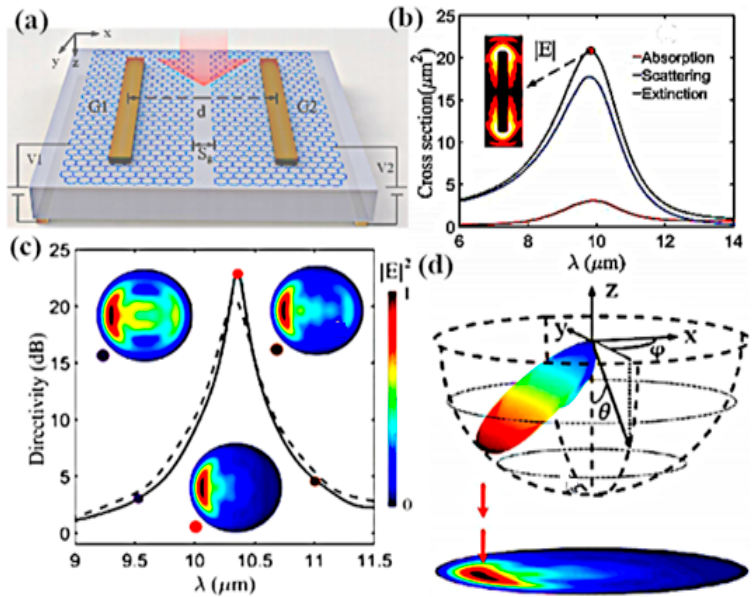
Figure 12. ( a ) Geometry of the graphene–metal nanostrip plasmonic antenna with the graphene placed under the nanostrips and two more strips beneath the quartz substrate where the gate voltage is applied to both graphene sheet. ( b ) Simulated extinction, absorption and scattering responses of the proposed antenna with a single gold nanostrip keeping the Fermi energy of the graphene sheet E f = 0.8 eV. The electric field distribution at the resonance peak shows that the electric field strength is greater at either side of the gold nanostrip. ( c ) Directivity pattern determined theoretically and from simulation; 3D scattering distribution intensity of far-field directivity pattern at different resonance frequencies with respect to increasing the chemical potential from 0 to 0.8 eV. ( d ) 2D projection of scattering intensity distribution of the far-field radiation lobe of the graphene gold nanostrip antenna at 10.3 µm. © 2018 Laser Physics Letters, IOP Publishing Ltd. Reprinted with permission from [139].